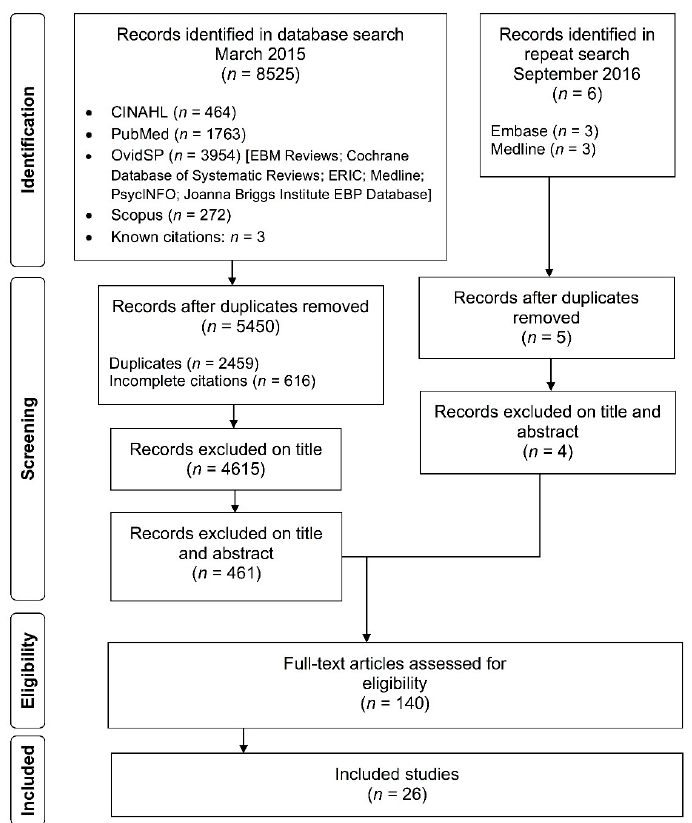
Figure 1. Preferred Reporting Items for Systematic Reviews and Meta-Analyses (PRISMA) [16] flow diagram of the search strategy.